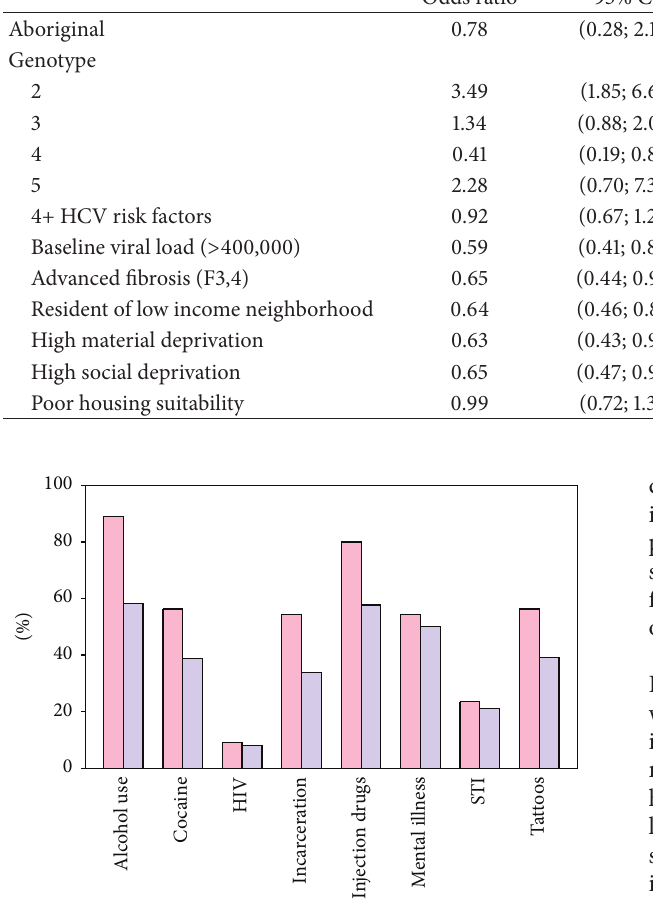
Figure 1: Factors associated with exposure and which act as barriers to engagement in HCV care and treatment (Aboriginal ( 𝑛 = 55 ) and non-Aboriginal ( 𝑛 = 1923 )